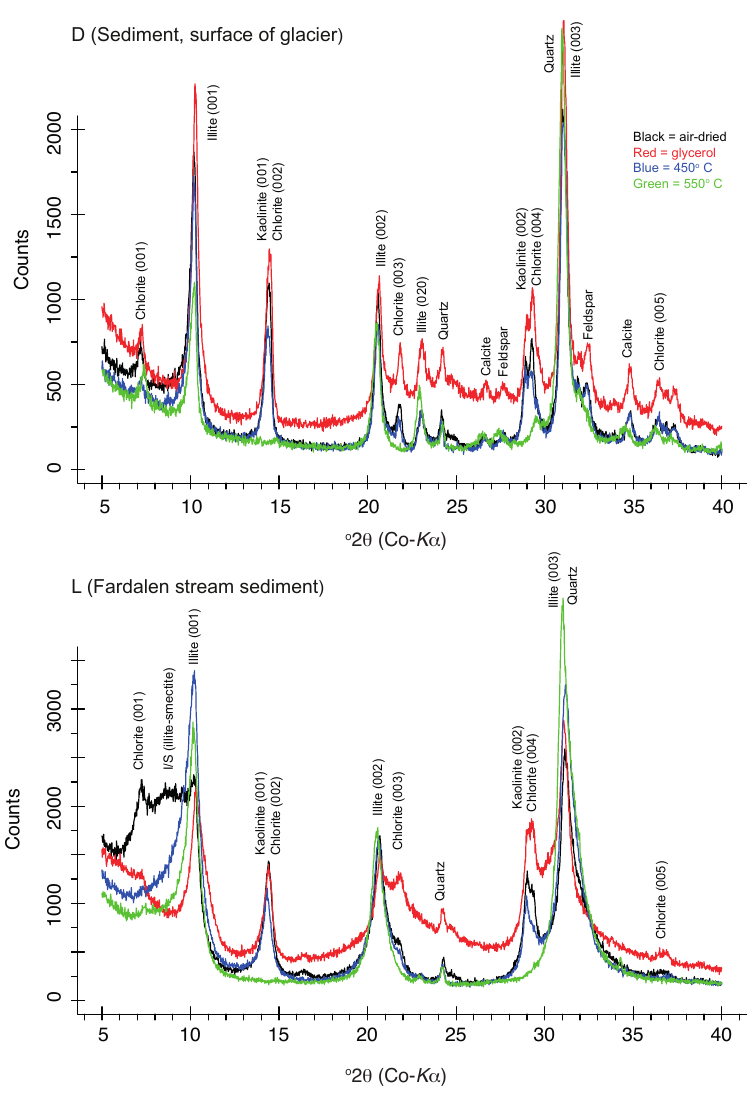
Figure 6. XRD patterns from two different samples: one with a high relative illite abundance (D) and one with low relative illite abundance and the clear presence of an expandable clay, likely an illite–smectite (I/S) mixed phase mineral (L).